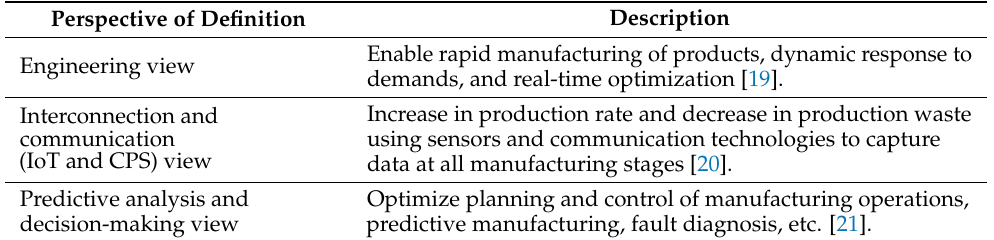
Table 1. Other definitions of the smart manufacturing system (modified from